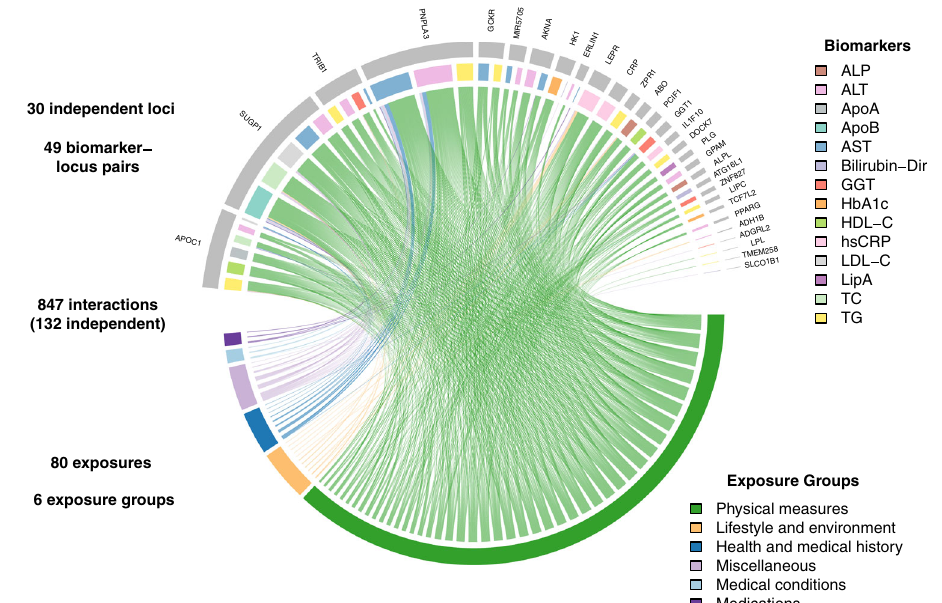
Fig. 3 Chord diagram displays GEI links between vQTL-biomarker pairs (top of circle) and exposures (bottom of circle). Lines correspond to interactions that are Bonferroni signi fi cant ( p < 2.38 × 10 − 7 ) for the associated variant, biomarker, and exposure based on two-sided p -values from linear regression. vQTL-biomarker pairs are colored according to biomarker and labeled with the nearest gene. Exposures are colored according to exposure